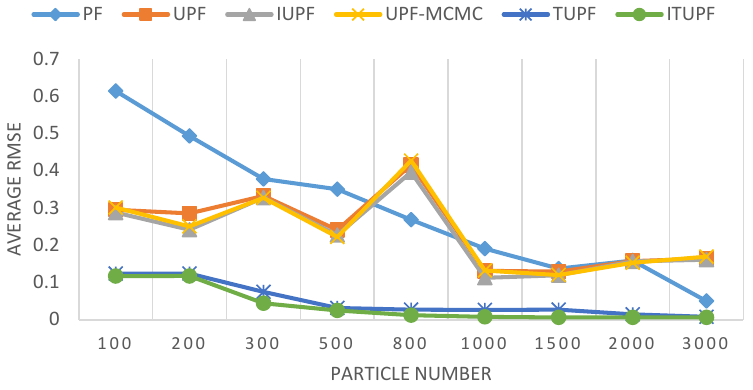
Figure 9. Particle number influence on the RMSEs of different particle